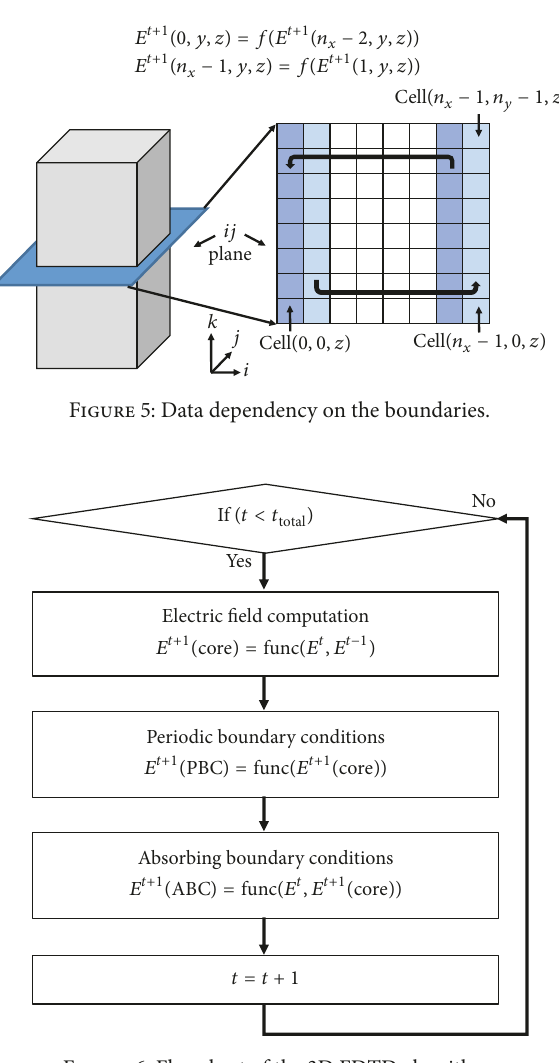
Figure 6: Flowchart of the 3D FDTD